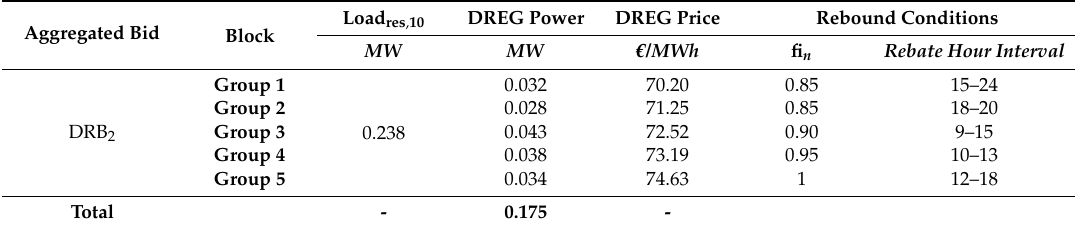
Table 6. Industrial area flexibility at hour